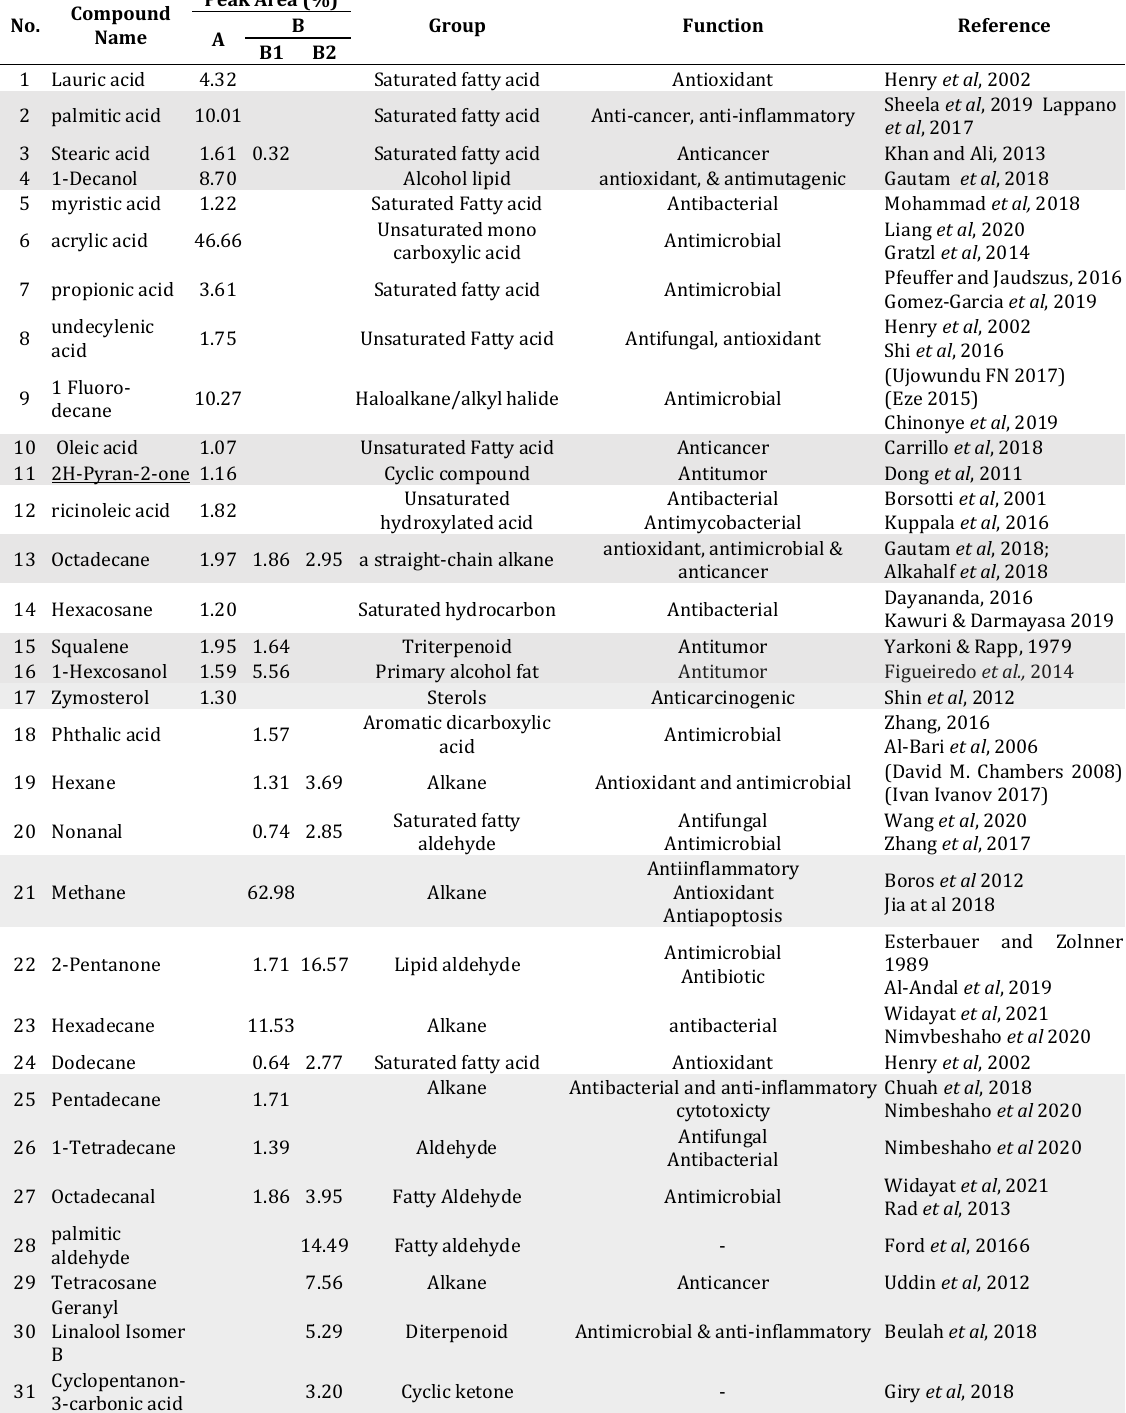
Table Ia. Profile of bioactive compound of control and treatment callus (Without and With Preservation)